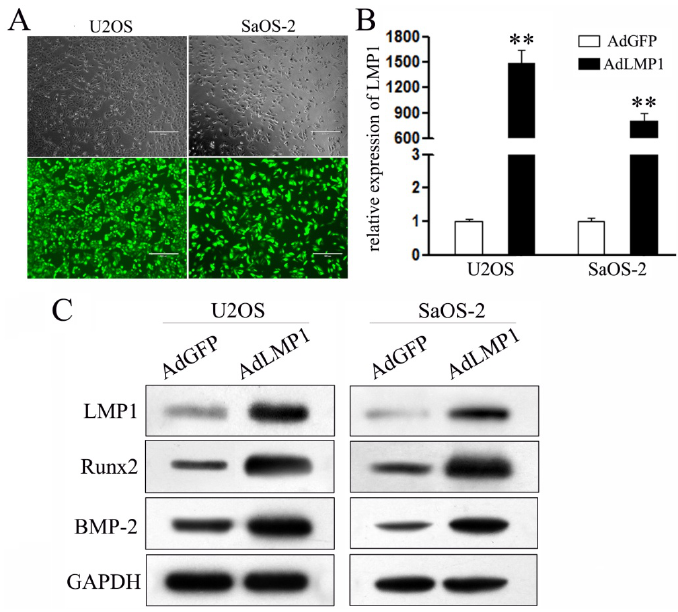
Figure 2. Restored LMP-1 expression in OS cells through infection with recombinant adenovirus. ( A ) Fluorescence microscopy detected the green fluorescence protein upon infection. Eighty percent of OS cells showed strong fluorescence upon infection with the AdLMP-1 at 48 h upon infection (×100); ( B ) Real-time-PCR was performed to determine the mRNA level of LMP-1 in OS cells infected with AdLMP-1 at MOI 10. Upon infection, the expression level of LMP-1 mRNA was significantly upregulated compared with cells infected with AdGFP; ( C ) Western Blot assays were performed to explore the expression of LMP-1 protein after infection with AdLMP-1. The expression of LMP-1 combined with its downstream genes, Runx2 and BMP-2, were all upregulated upon infection. ** p <